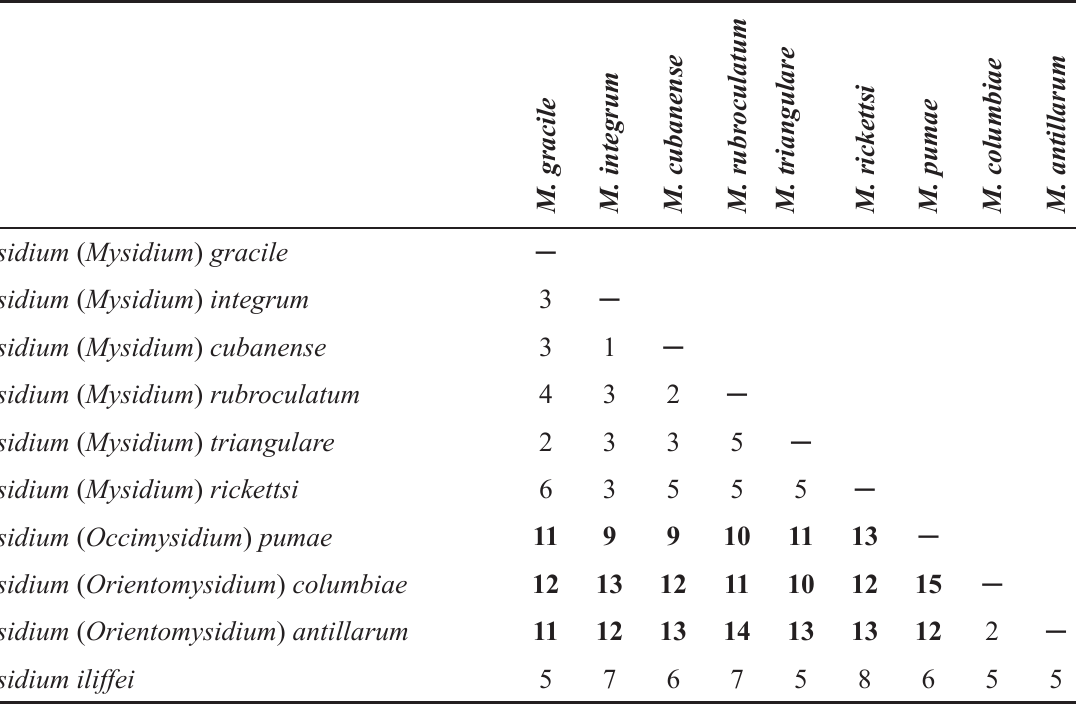
Table 3. Number of documented morphological differences between and within the proposed subgenera of Mysidium Dana, 1852. Bold print marks differences between species pertaining to different subgenera.